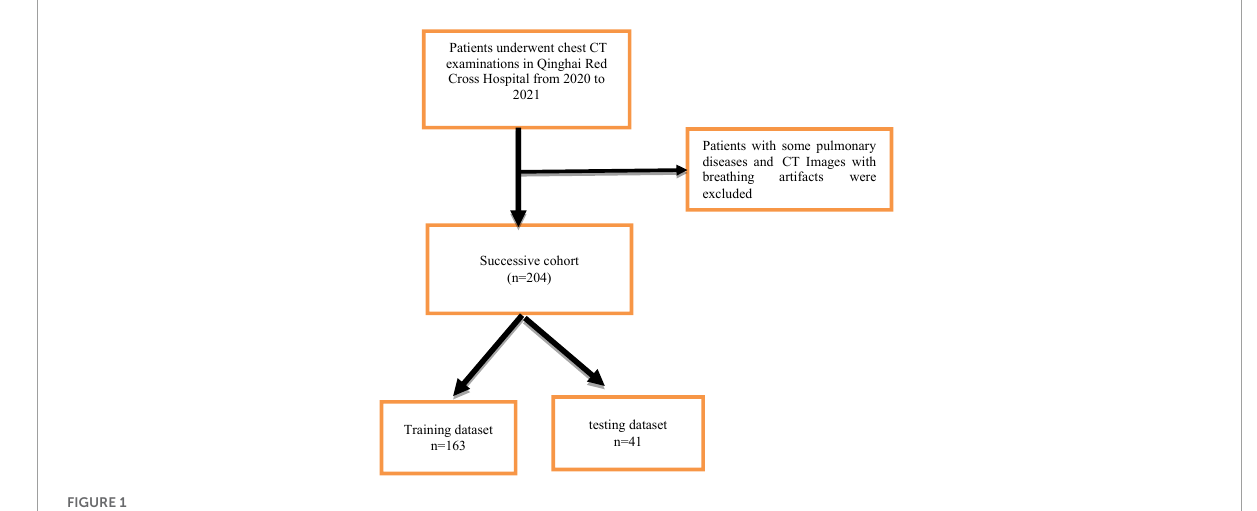
FIGURE1 Flowchart of patients for inclusion in the successive cohort.